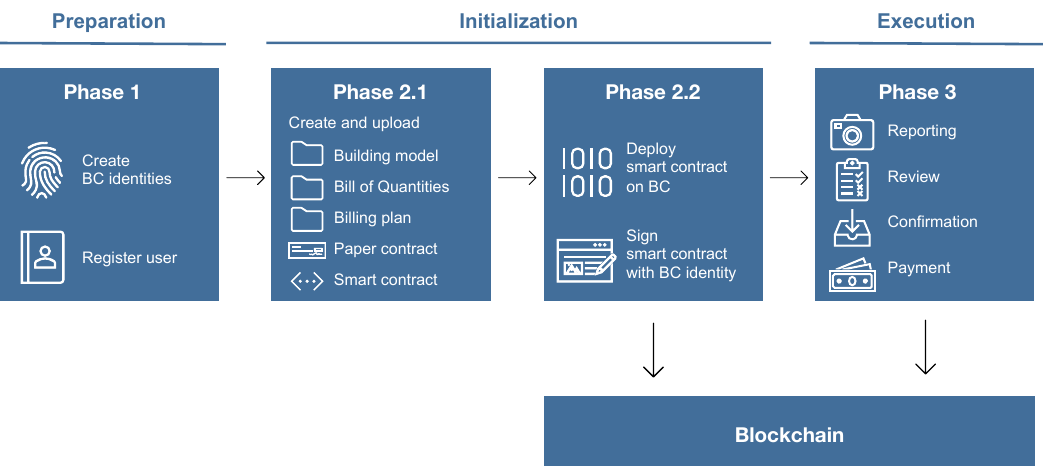
Figure 2. Three phases of the workflow for managing smart